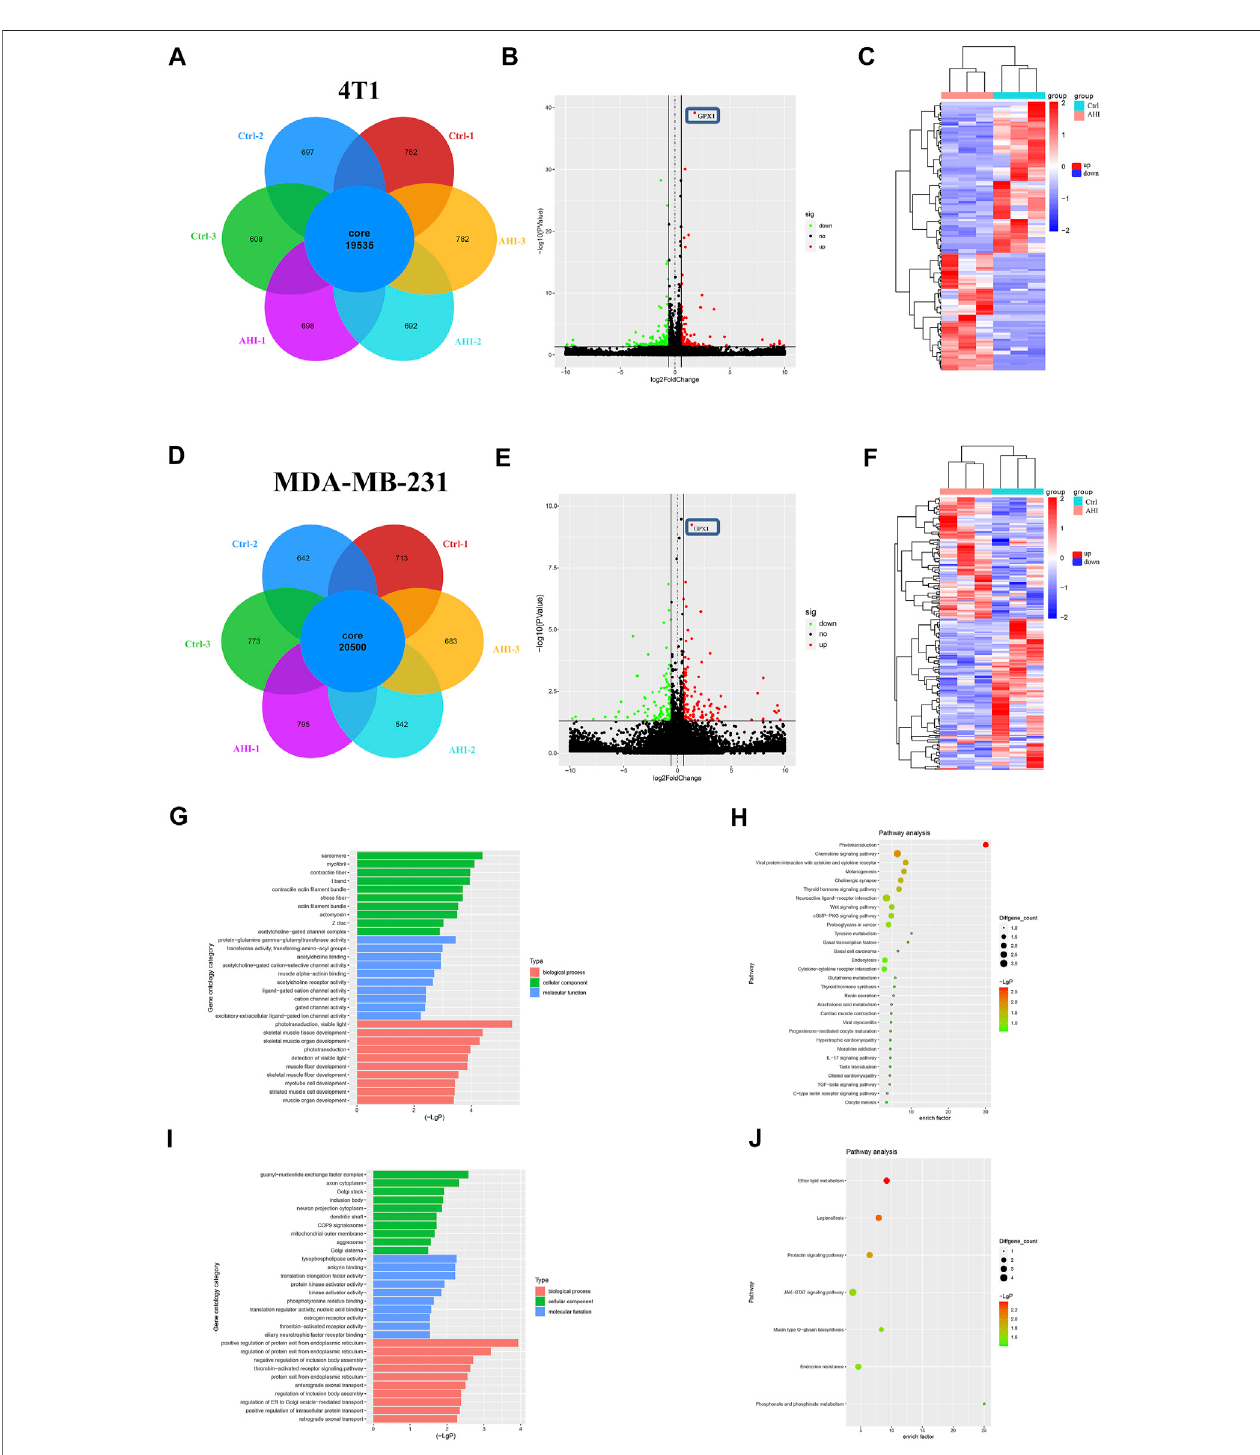
FIGURE3| ScreeningofDEGsbyRNA-seqandenrichmentanalysis. (A , D) AnalysisofDEGsafterAHItreatment. (B , E) Identi fi cationofDEGs. (C , F) Volcanoplot of the DEGs with FDR ≤ 0.05 and fold change ≥ 1.5. (The red dots indicate upregulated DEGs, green ones indicate downregulated DEGs, and black ones indicate no signi fi cant difference. The heatmap was drawn to show the DEGs.) (G , I) GO functional enrichment and (H , J) KEGG pathway enrichment of the DEGs.